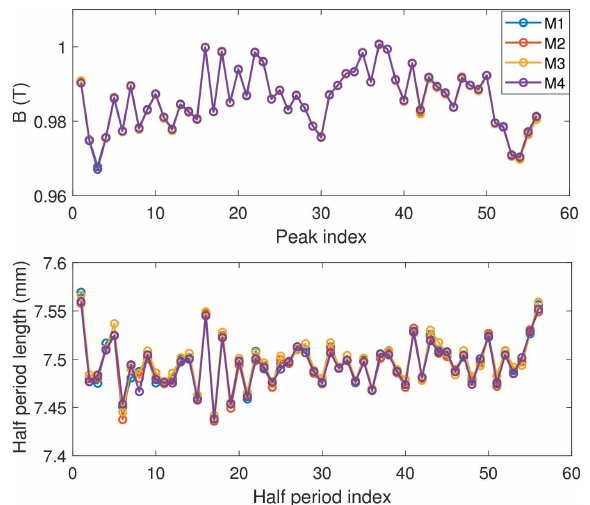
Figure 11 Absolute values of field peak and the half-period length for the center field with 450 A main current and 25 A correction current for four repeated measurements.